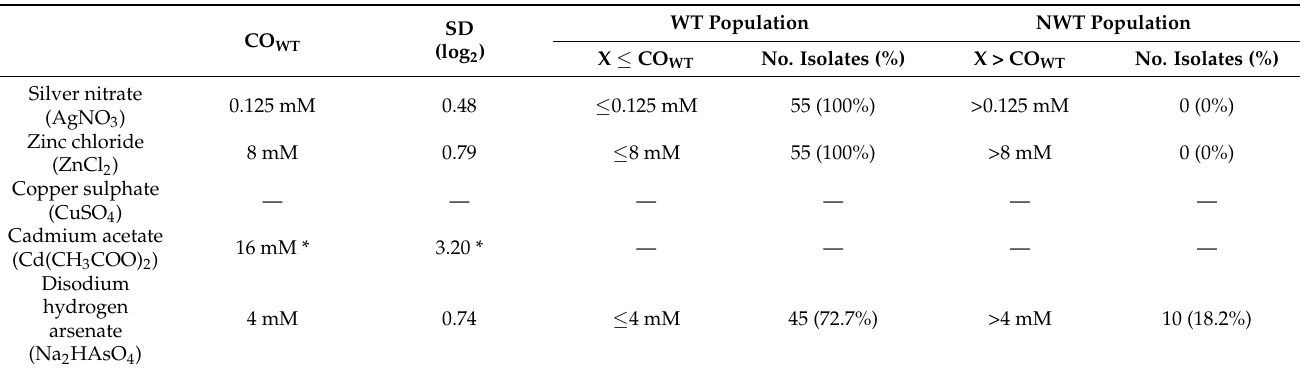
Table 2. Cut-off (CO WT ) values of S. aureus for the five heavy metals. The CO WT values and estimated wild-type (WT) and non-wild-type (NWT) populations were determined based on the MIC distributions using